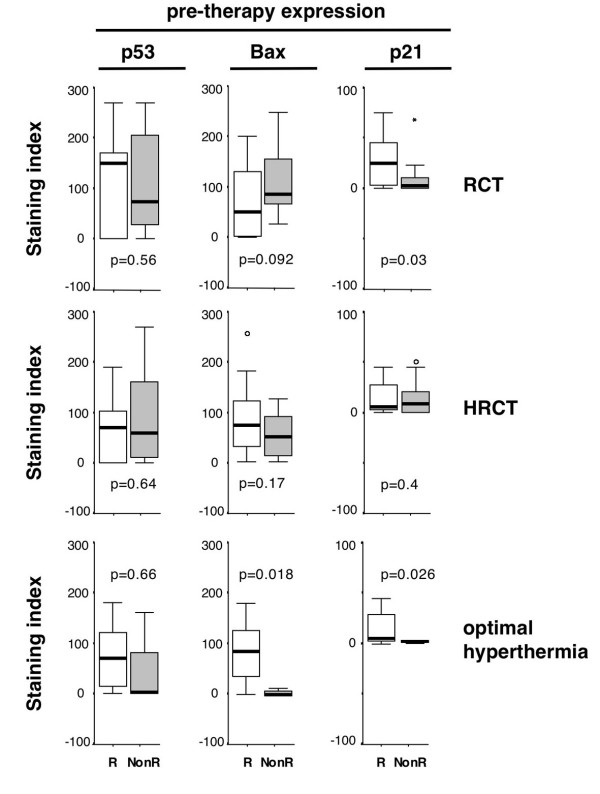
Pre-therapeutic expression of p53, Bax, p21CIP/WAF-1 and response to therapy in rectal carcinomas. Box plot analysis of staining indices (STI) for p53, Bax and p21CIP/WAF-1. White bars: Responders (R), grey bars: Non-responders (NonR), RCT: radiochemotherapy. (responders n = 21, non-responders n = 14), HRCT: hyperthermic radiochemotherapy (responders n = 18, non-responders n = 13), optimal hyperthermia: subgroup of HRCT, definition see text (responders n = 13, non-responders n = 3).